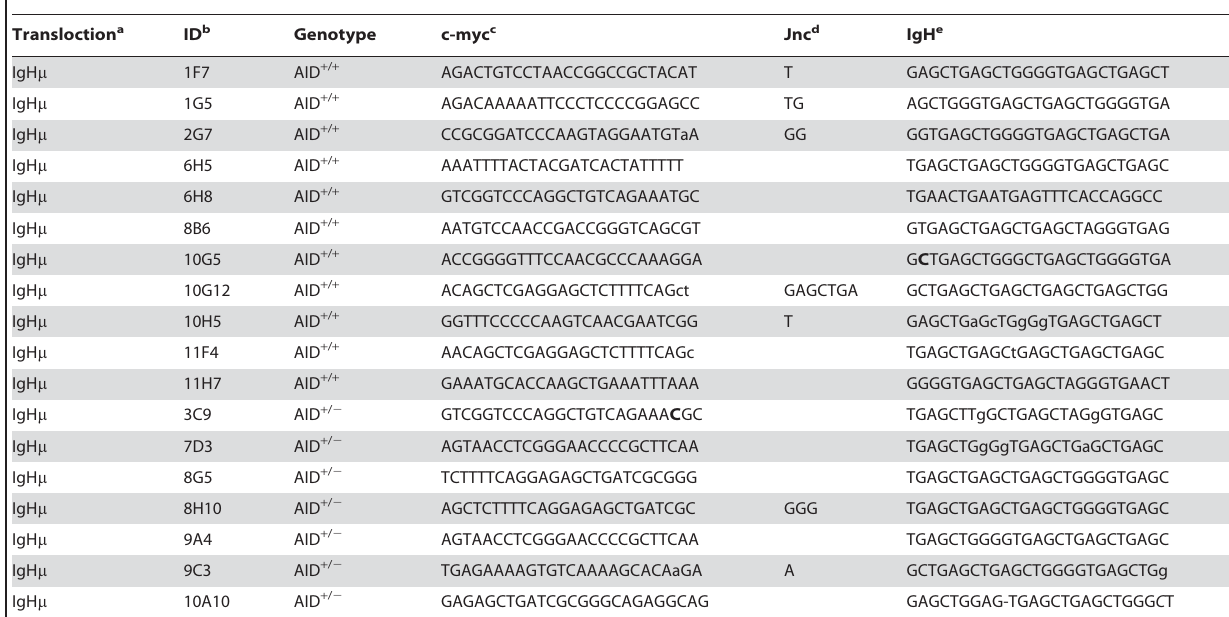
Transloction a ID b